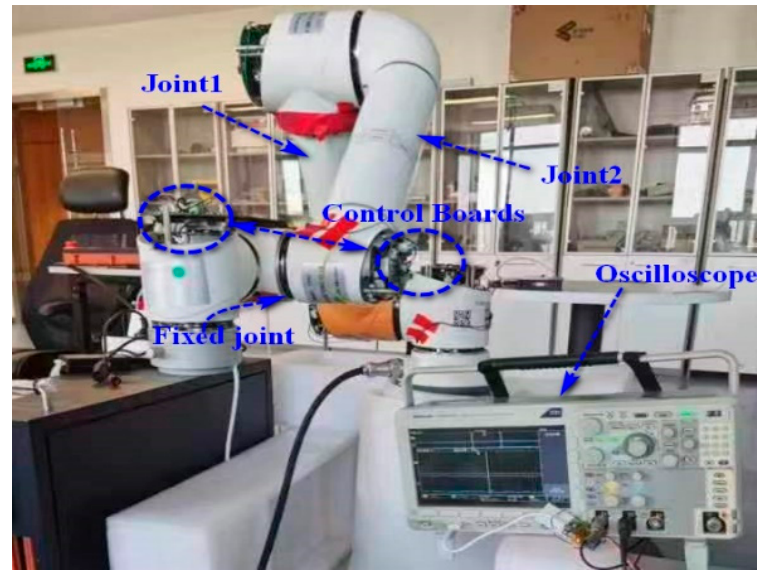
Figure 5. Robotic experimental platform.